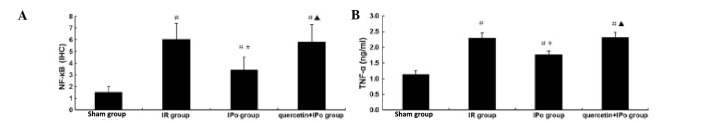
(A) Expression of NF-κB and (B) TNF-α expression levels, in the four experimental groups at 6 h post-reperfusion. #P<0.05, as compared with the sham group; *P<0.05, as compared with the IR group; ▲P<0.05, as compared with the IPo group. S, control group; IR, ischemia-reperfusion; IPo, ischemic postconditiong; IHC, immunohistochemistry; TNF-α, tumor necrosis factor-α; NF-κB, renal nuclear factor kappa-light-chain-enhancer of activated B cells.